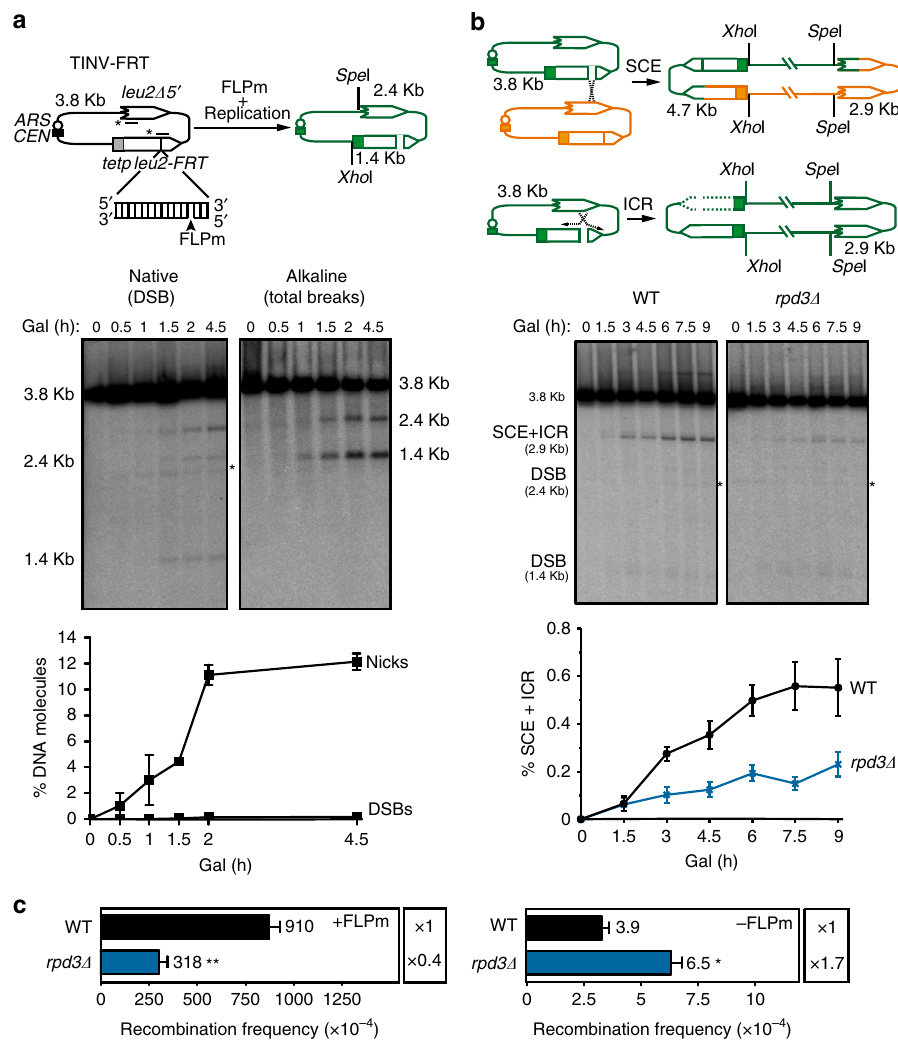
Fig. 4 An FLP nickase-based system con fi rms the role for Rpd3 in SCR. a Analysis of the formation of nicks and DSBs after FLPm induction in the wild-type (WFLP) strain transformed with the pTINV-FRT plasmid. A scheme of the TINV-FRT system before and after the FLPm-induced nick is converted to a DSB by replication and representative Southern blots of the time-course analysis after FLPm induction after native and alkaline gel electrophoresis are shown ( n = 2). b Representative Southern blots and quanti fi cation of the 2.9-kb SCE + ICR fragments during a time-course experiment after FLPm induction performed at 37 °C in wild type (WFLP) and rpd3 Δ (WFRPD3) strains transformed with pTINV-FRT ( n ≥ 3). A scheme of the TINV-FRT system and SCE and ICR intermediates produced after FLPm-induced replication-born DSBs is shown. c Analysis of spontaneous ( − FLPm) and FLPm-induced ( + FLPm) recombination frequencies at 33 °C in wild type (WFLP) and rpd3 Δ (WFRPD3) strains transformed with pTINV-FRT ( n = 3). In a and b , fragments generated after Xho I – Spe I digestion are indicated with their corresponding sizes in kb and were detected by Southern blot hybridization with a LEU2 probe (line with an asterisk). Asterisks beside Southern blots indicate non-speci fi c hybridization. Means and SEM are plotted in all panels. In c , * p ≤ 0.05; ** p ≤ 0.01 (two-tailed Student ’ s t- test). See also Supplementary Fig. 3A. Data underlying these fi gures are provided as Source Data fi